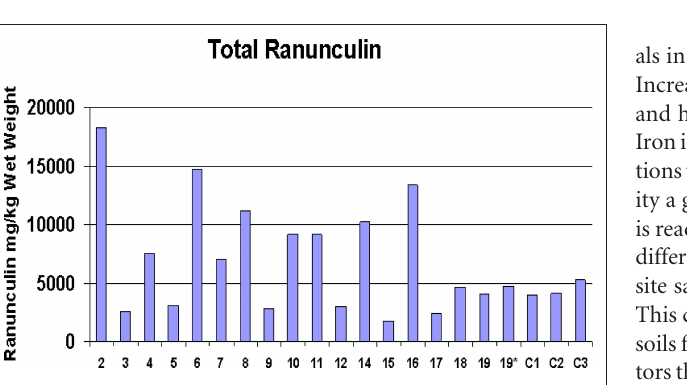
FIGURE 4 | Soil nitrogen. Soil nitrate nitrogen and ammonium nitrogen (mg/kg) per site (EGS and controls).